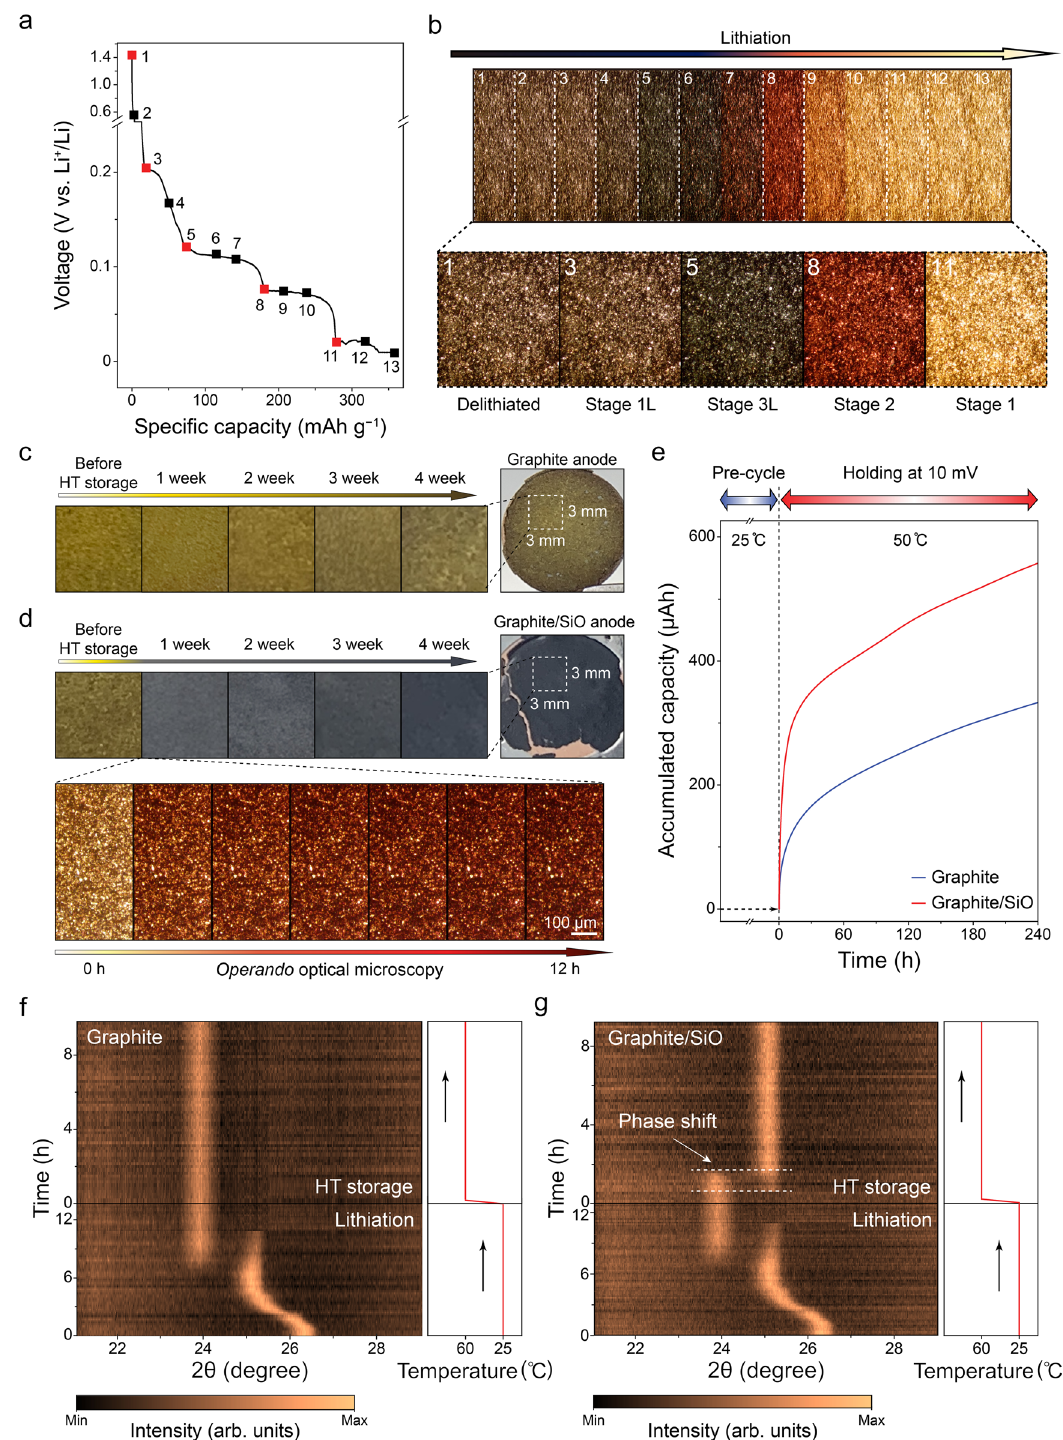
Fig. 2 | Thermal self-discharge visualized by stage transition of graphite. a Voltagepro fi le ofgraphitehalfcellduringlithiationand b correspondingoptical images of graphite electrode obtained from operando optical microscopy. Among sixphases of lithiated graphite (stage 1L, 4L, 3L, 2L,2, and 1), stage4Land 2Lwere not represented since they were indistinguishable. c , d Postmortem photographs